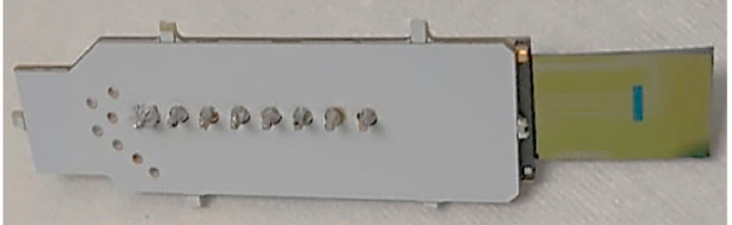
Figure 2. Image of a passivated chip in the Biovici ‘Sensor-Connect’ connector for real-time resistance measurements.